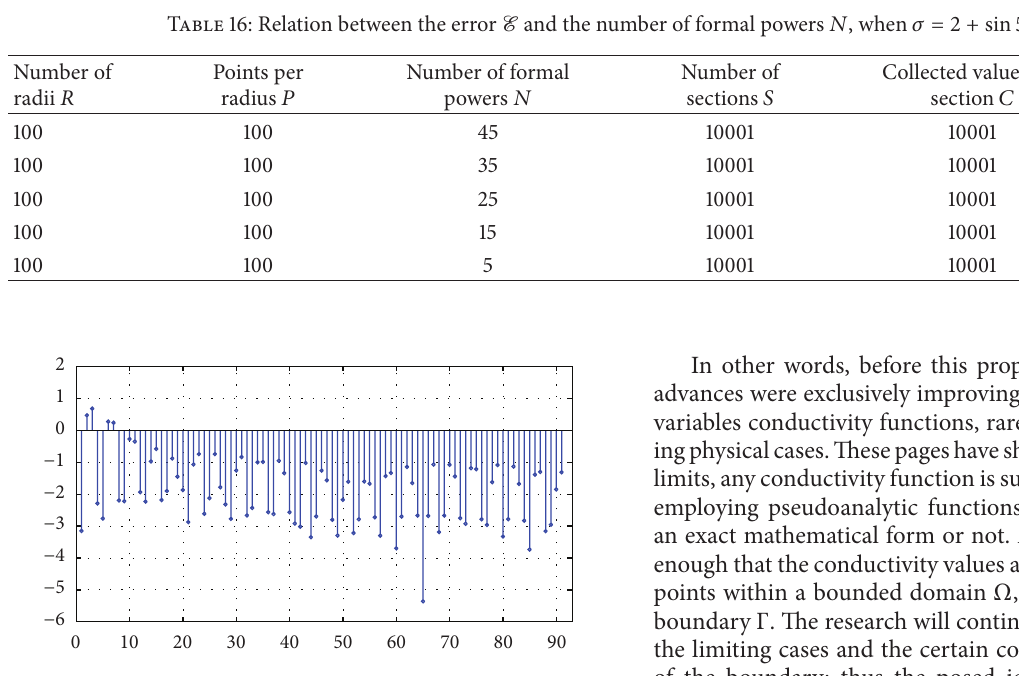
} corresponding to the conductiv- 𝑛 −1 .